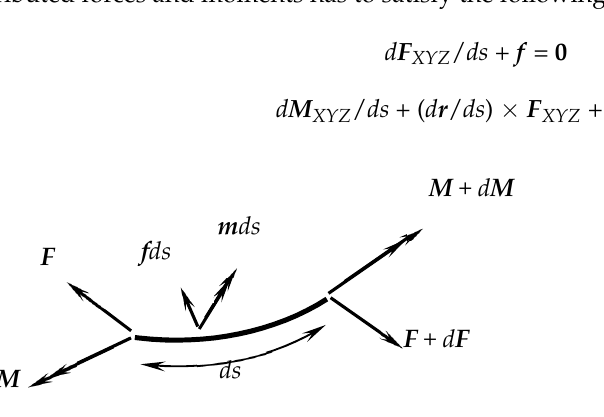
Figure 2. Free-body diagram of the beam segment with distributed forces and distributed